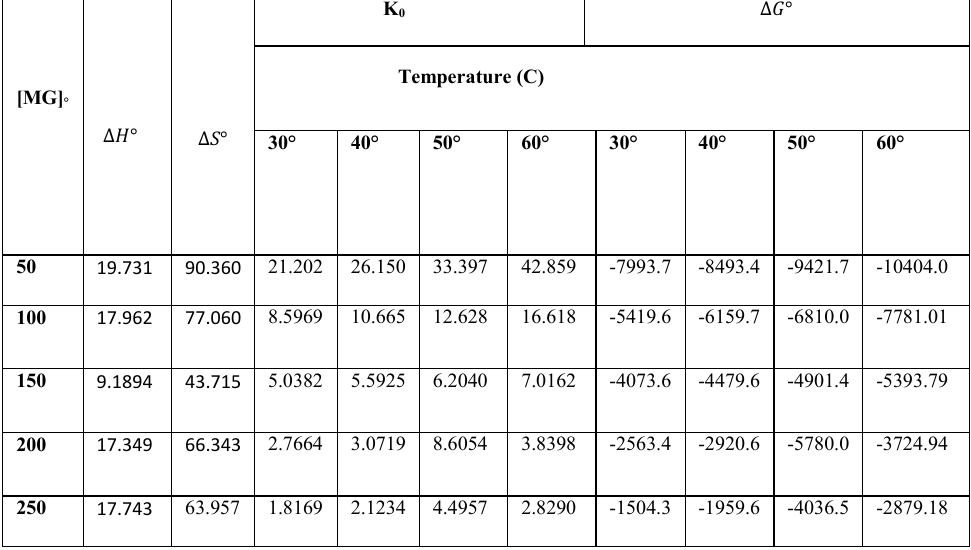
Table 4. Equilibrium constant and thermodynamic parameters for the adsorption of Malachite Green onto activated